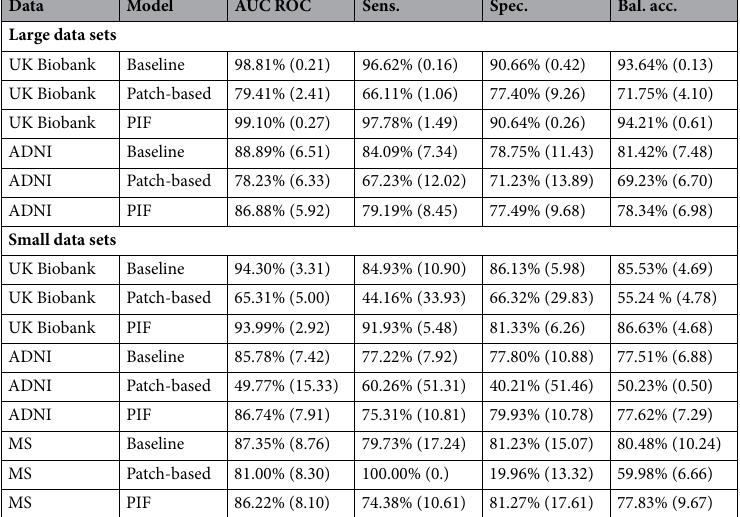
Table 2. Results of the binary classification tasks. Area under the receiver-operating curve, sensitivity, specificity, balanced accuracy are reported as averages over 10 repetitions. Standard deviation is reported in parentheses.